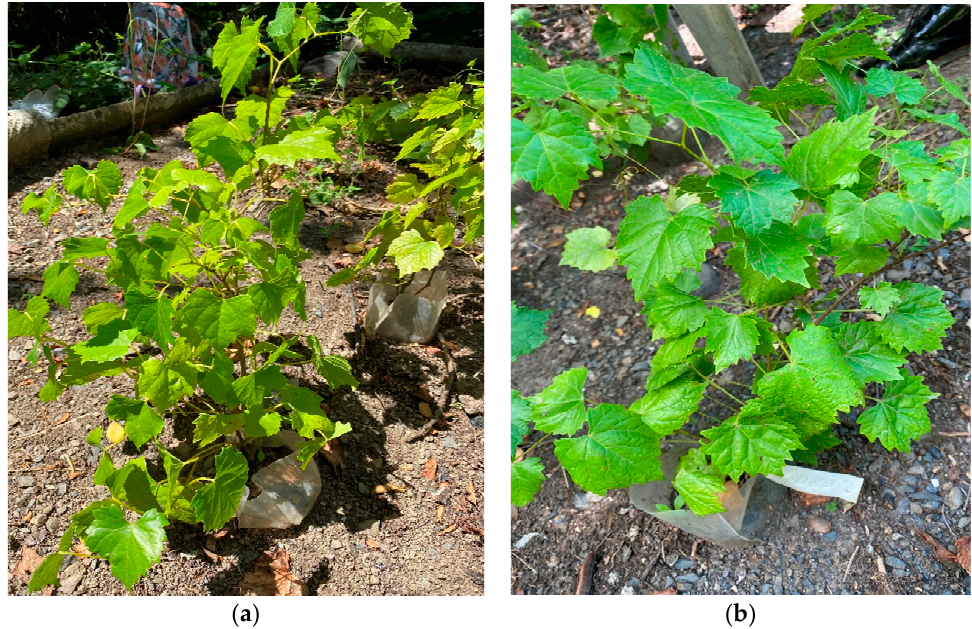
Figure 2. Three-year-old rooted seedlings obtained from selfing (S1) of M. rotundifolia cv. Dixie and grown in the experimental vineyard of the Institute of Viticulture and Winemaking ‘Magarach’ (Cri- mea): ( a , b ) vines with varying morphological characteristics. (Crimea): ( a , b ) vines with varying morphological characteristics.